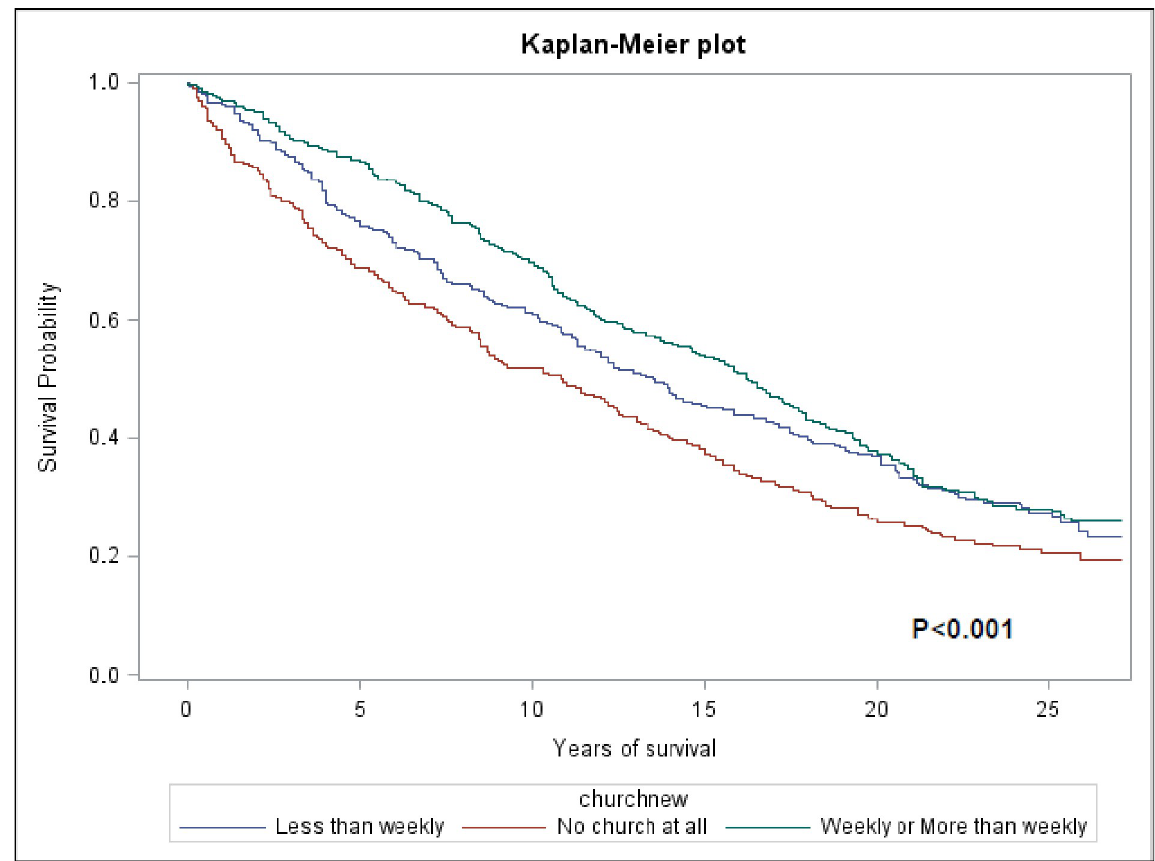
Fig 2. Unadjusted Kaplan-Meier curves for all-cause mortality by church attendance.